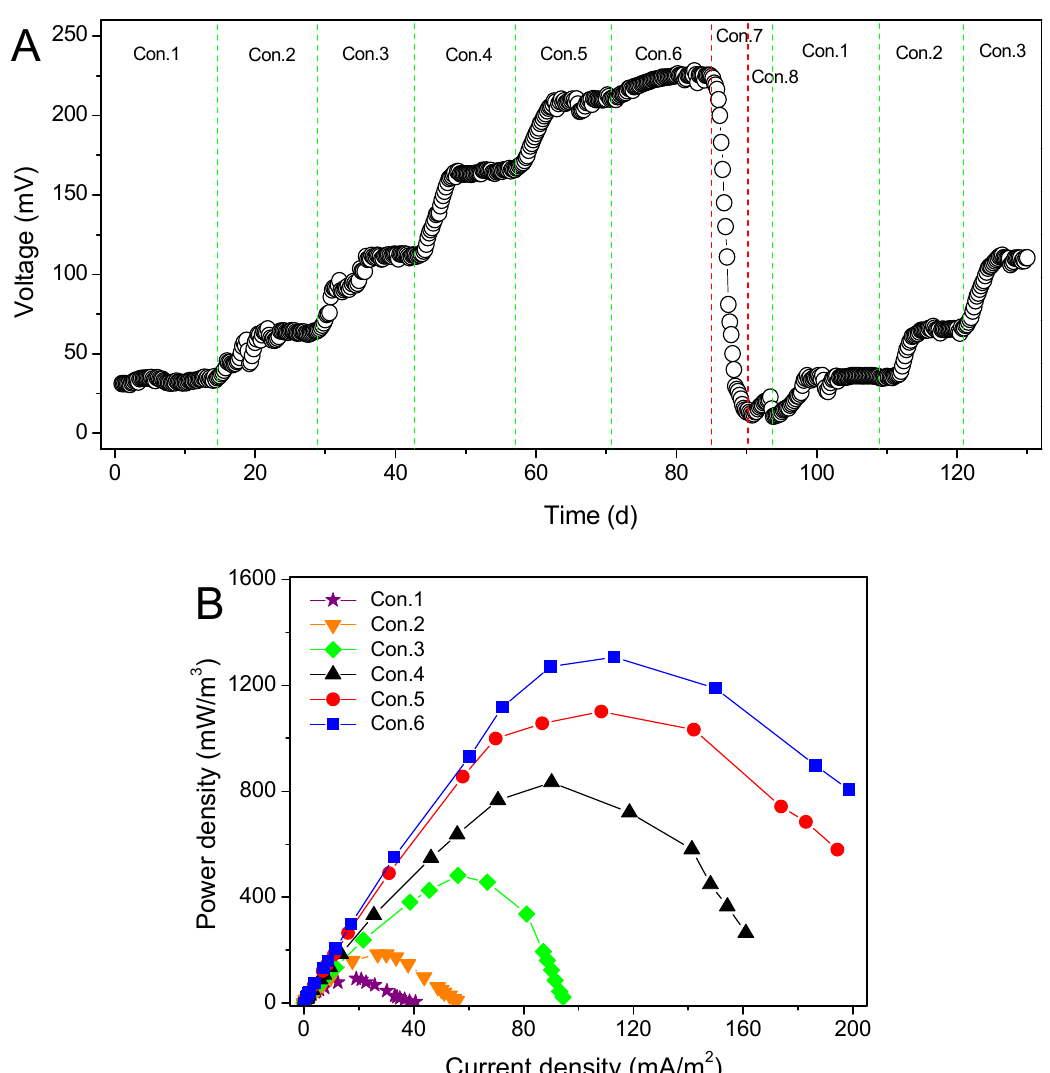
Figure 3. Profiles of ( A ) output voltage and ( B ) power density as a function of current output under different influent nitrogen concentrations (NH 4+ ‐ N concentrations: Con.1: 25 mg/L, Con.2: 50 mg/L, Con.3: 100 mg/L, Con.4: 150 mg/L, Con.5: 200 mg/L, Con.6: 250 mg/L, Con.7: 300 mg/L; Con.8: 0 mg/L) in the anode anammox MFC.